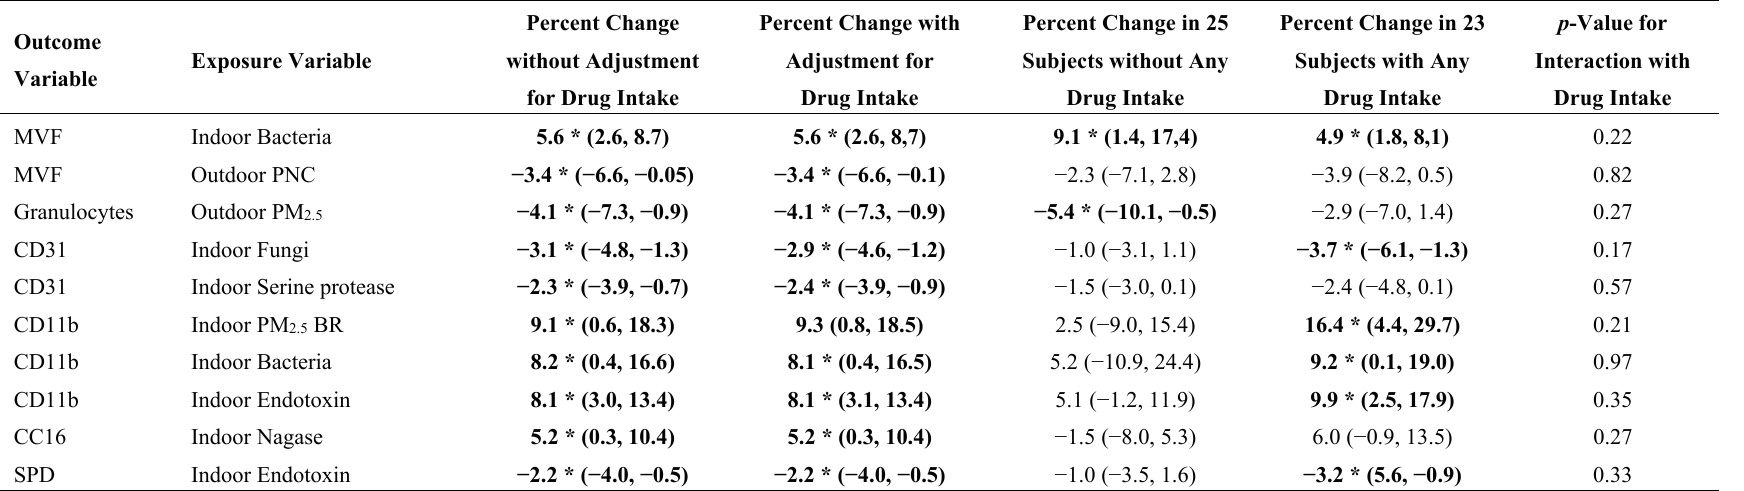
Table 5. Percent changes (95% confidence interval) in outcome levels associated with one interquartile range increase in indoor and outdoor exposures, estimated by mixed-effects models with the natural logarithm of the outcomes, accounting for correlation between repeated measurements within subjects and with subjects nested in residence; all models were adjusted for age, gender, BMI, indoor filtration and days of measurements. Only associations statistically significant as outlined in Table 4 are included and here presented without and with further adjustment for intake of any drug and stratified into groups of subjects not taking or taking any